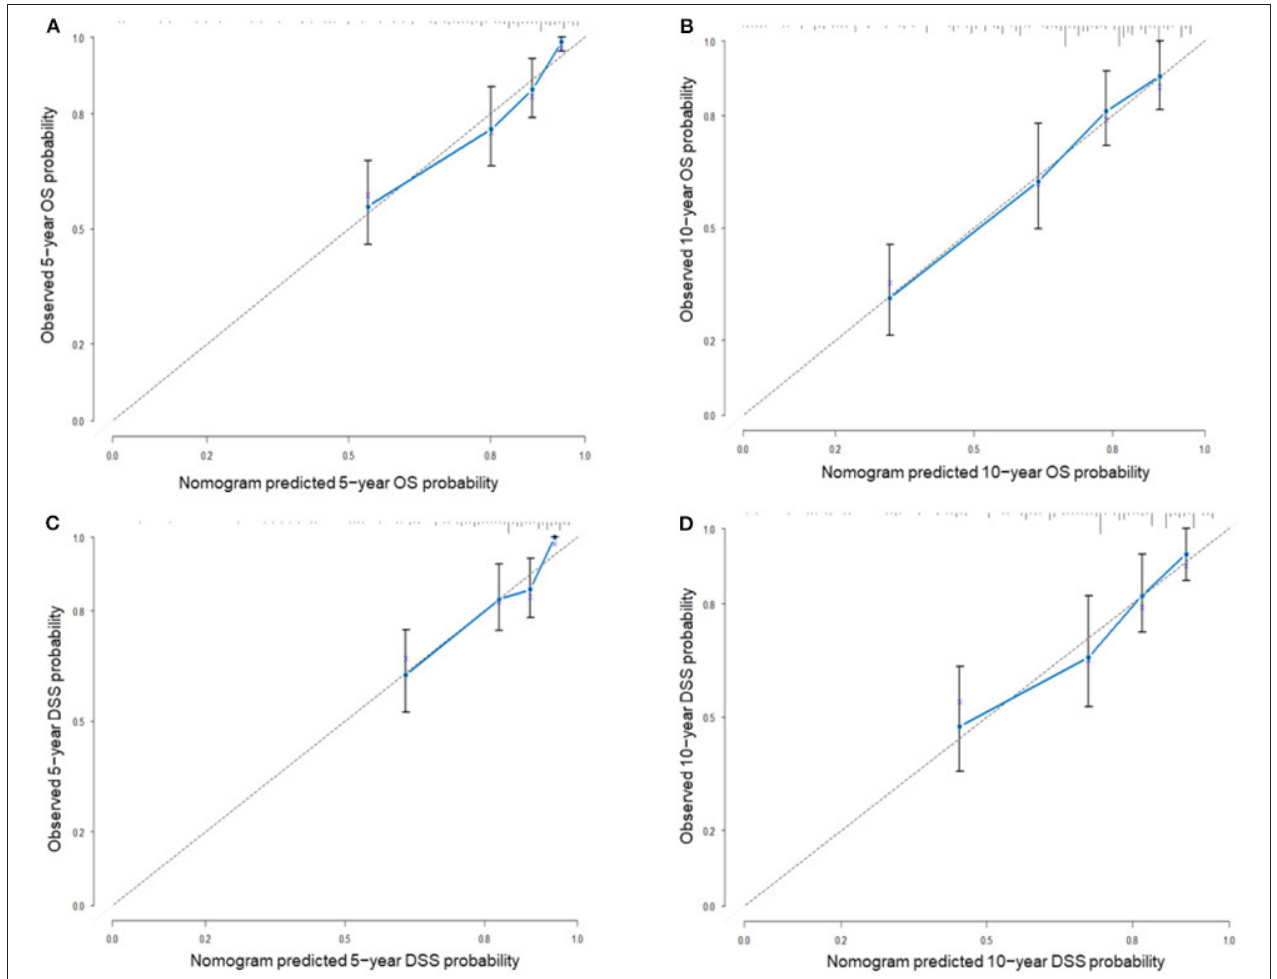
FIGURE 4 | The calibration plots for internal validation of (A) actual 5-year OS and (B) 10-year OS; (C) actual 5-year DSS and (D) actual 10-year DSS. The 45-degree dashed line represents an ideal match between the actual observed survival (Y-axis) and nomogram-predicted survival (X-axis). The perpendicular line represents 95% confidence intervals. Closer distances from the points to the dashed line mean a higher prediction